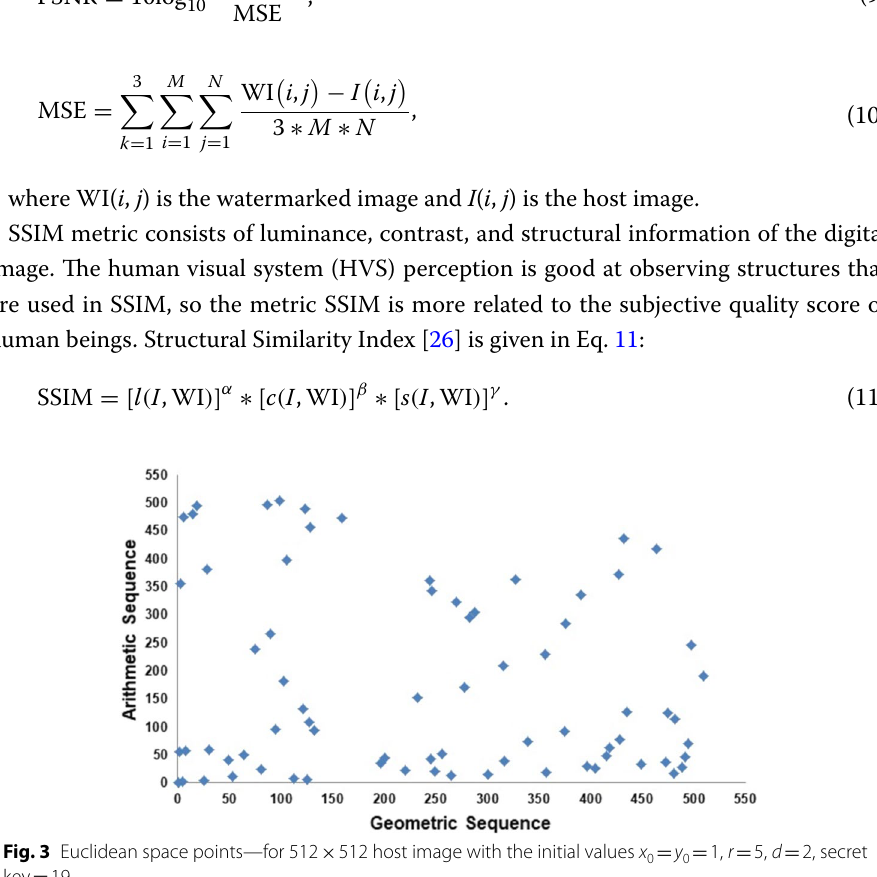
512 host image with the initial values x 0 ×